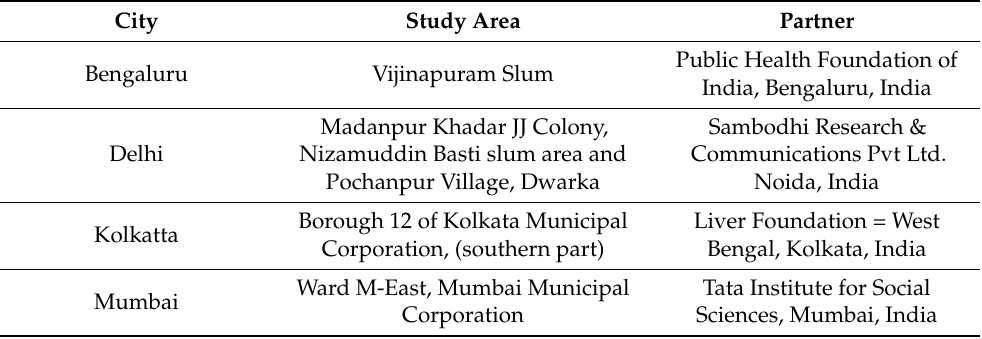
Table 2. Showing study